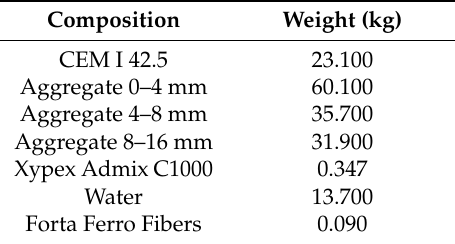
Table 1. Composition of